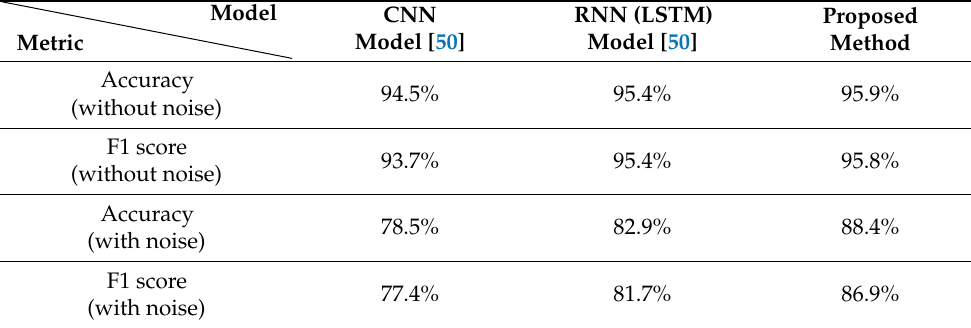
Table 3. The mean accuracy of different DNN methods on